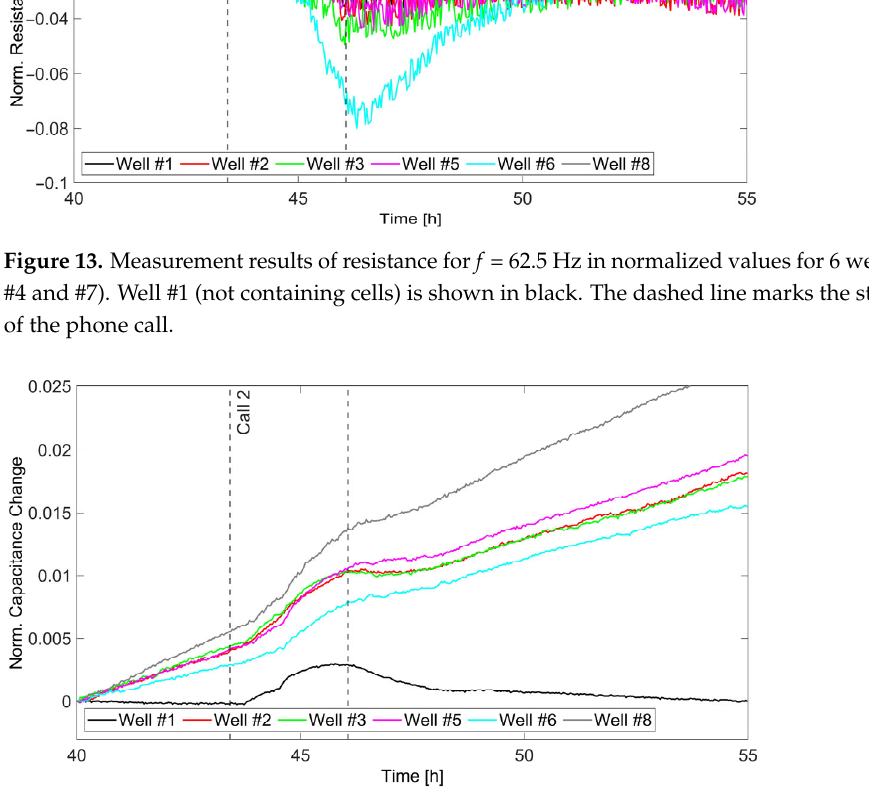
Figure 14. Measurement results of capacitance for f = 1 kHz in normalized values for 6 wells (without #4 and #7). Well #1 (not containing cells) is shown in black. The dashed line marks the start and end of the phone call.